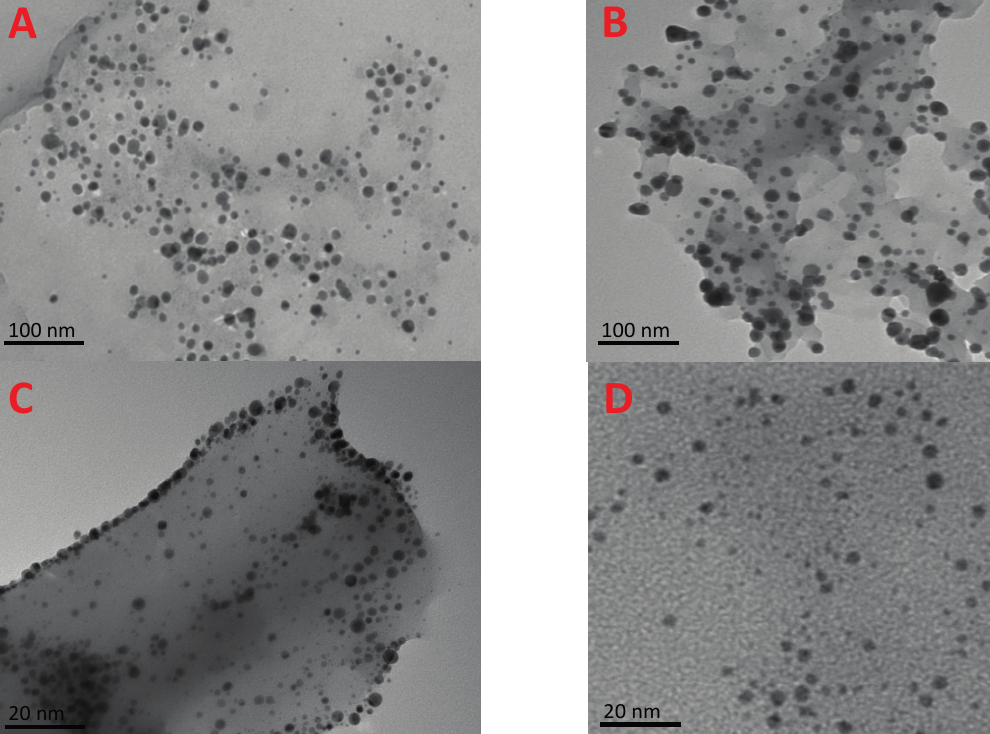
Figure 7. TEM analysis of silver nanoparticles obtained after thermal polymerization using AgSbF 6 /NVK/DPSi (1%/2%/2% w/w ) system in ( A ) TMPTA, ( B ) St, ( C ) EPOX and ( D ) IPN